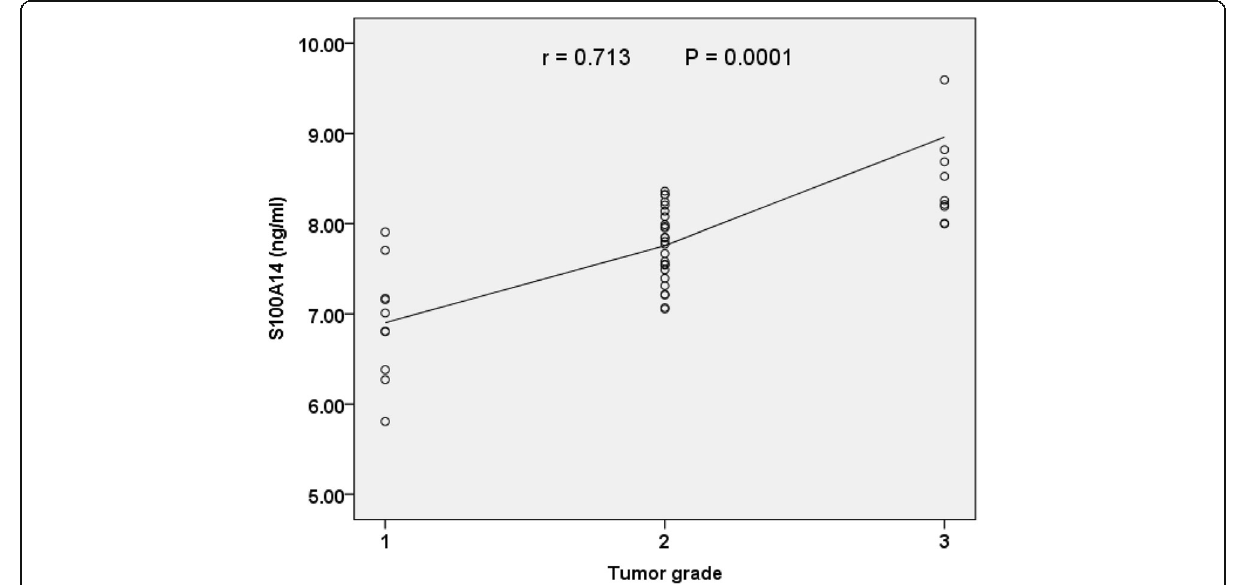
Fig. 2 The correlation between S100A14 serum level and breast cancer tumor grade